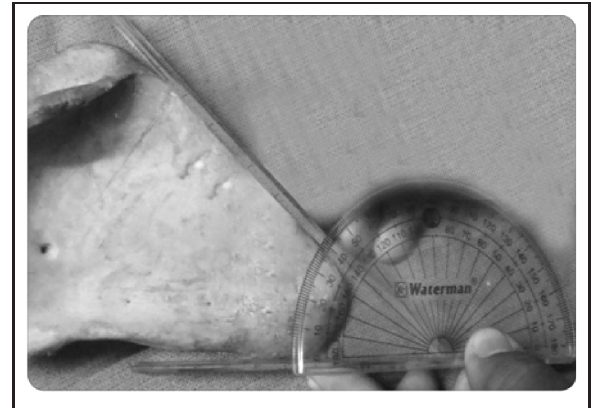
Figure 3. Measurement of Inferior Angle. 3. Lateral angle: It was measured as an open angle where the superior and the lateral or the axillary borders are wedged by the glenoid fossa. 2 For measuring this angle a scale was placed along the lateral border touching the infraglenoid tubercle and another scale was placed along the superior border and angle between both was measured with the help of protractor 2 (Figure 1 and 4)